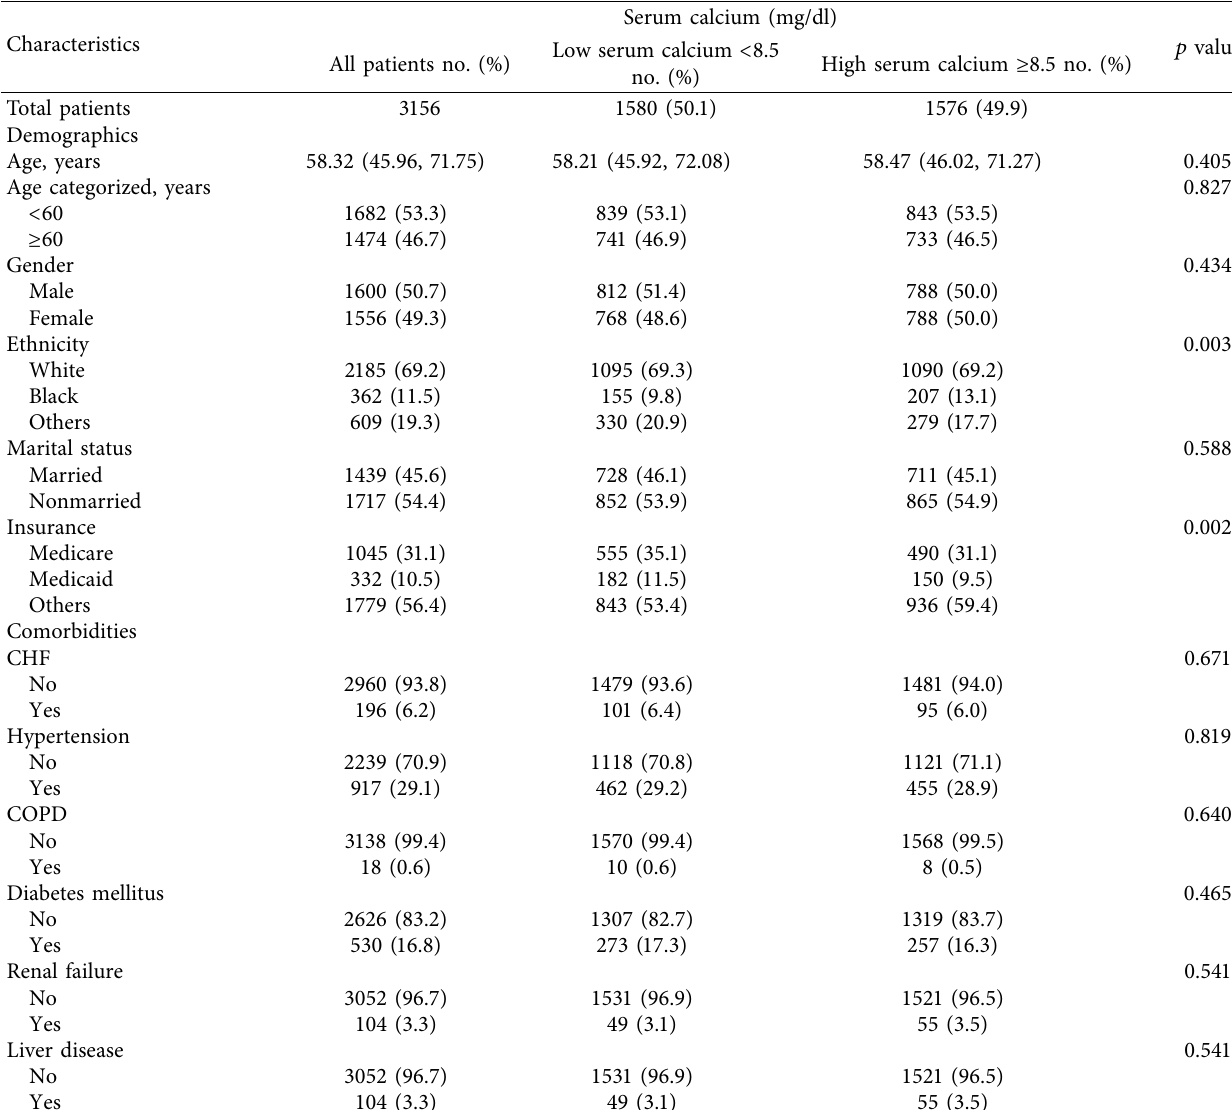
Figure 2: Relative risk for a hospital length of stay (LOS) > 2 days, > 5 days, and > 7 days according to the serum calcium level. The solid black lines represent aORs based on restricted cubic splines for the serum calcium level. The dotted curve represents upper and lower 95% CIs. Adjustment factors are the same as those in the extended model of Table 2. Table 1: Participants’ baseline